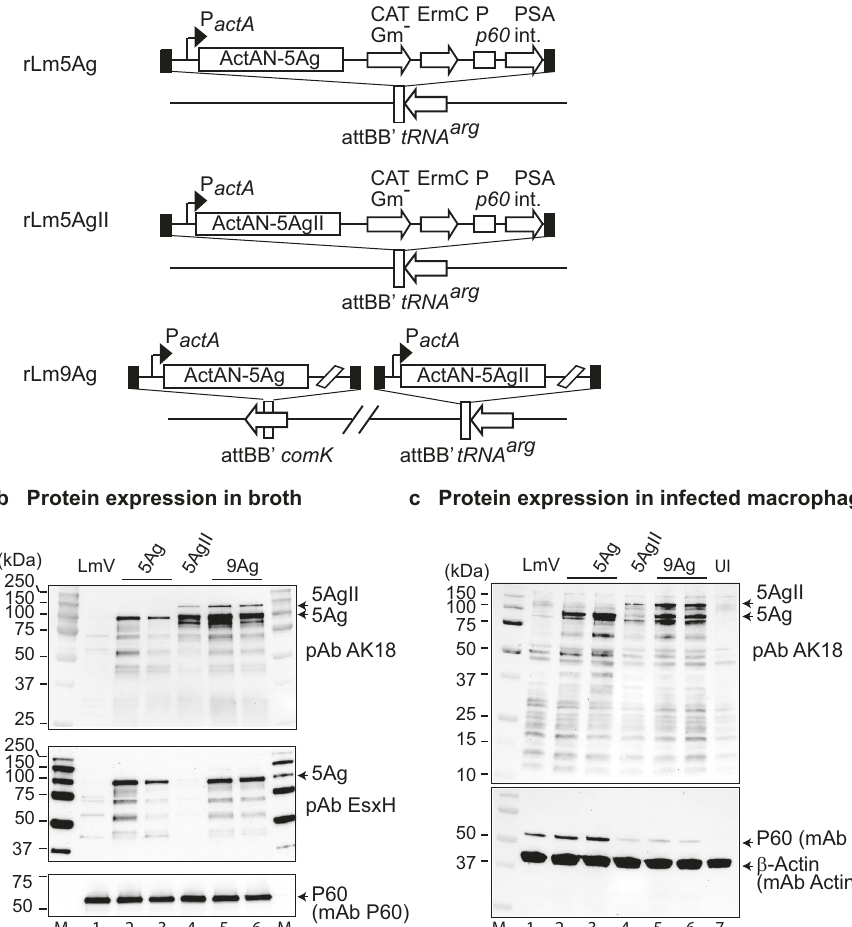
Fig. 1 Construction and veri fi cation of rLm9Ag vaccine. a Diagram of rLm5Ag and rLm9Ag vaccine candidates. Expression cassettes ActAN-5Ag for rLm5Ag (top panel) and ActAN-5AgII for rLm5AgII (middle panel) driven by the Lm actA promoter were integrated at the tRNA arg loci of the corresponding rLm chromosome ; expression cassettes ActAN-5Ag and ActAN-5AgII for rLm9Ag were integrated at the comK and tRNA arg loci of the Lm chromosome, respectively (bottom panel). b Expression of heterologous and homologous proteins by rLm vaccine candidates grown in broth medium. Stocks of rLm vaccine candidates were inoculated into Brain Heart Infusion (BHI) medium and grown overnight at 37 °C with agitation. The overnight culture was collected by centrifugation, resuspended in PBS supplemented with Halt Proteinase Inhibitor (Thermo Fisher Scienti fi c), and lysed in SDS buffer. Equivalent amounts of bacterial lysates of each rLm were analyzed by Western blotting sequentially using rabbit polyclonal antibody to ActAN (pAb AK18) (top panel), rabbit polyclonal antibody to Mtb EsxH (middle panel); and monoclonal antibody to Lm P60 (serving as a loading control). The membrane was stripped before re-probing. c The murine macrophage-like (J774A.1) cells were uninfected (UI) or infected at a MOI of 10 with LmVector or an rLm vaccine expressing Mtb 5Ag, 5AgII, or 9Ag that had been grown to stationary phase. At 5.5 h post-infection, the infected cells were lysed and subjected to Western blotting using polyclonal antibody AK18 (upper panel); the membrane was stripped and re-probed with a monoclonal antibody to Lm P60 and a monoclonal antibody to cellular protein β -actin (lower panel), as indicated on the right border of each panel. In both panels b and c : M, protein standards; Lane 1, LmVector (LmV); Lanes 2 and 3, two clones of rLm5Ag expressing ActAN-Mpt64-EsxH-EsxA-EsxB-r30 from the tRNA arg locus; Lane 4, rLm5AgII expressing ActAN-Mpt64-EsxN-PPE68-EspA-TB8.4 from the tRNA arg locus; Lanes 5 and 6, two clones of rLm9Ag expressing a total of 9 different antigens, ActAN-5Ag from the comK locus and ActAN-5AgII from the tRNA arg locus; lane 7 (Panel c only), uninfected cells. On the left border of each panel are listed the sizes (kDa) of the molecular mass standards. Proteins of interests are indicated with arrows to the right of the protein band. Estimated Mw of